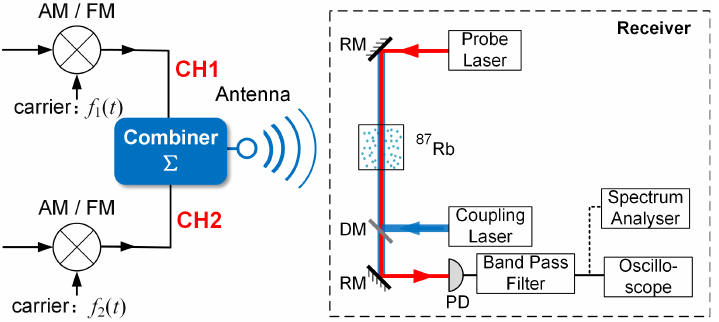
Figure 1. The experimental set-up. Frequency division multiplexing (FDM) receiver basing on Rydberg atoms is shown in the right part. Abbreviations: RM: reflector mirror; DM: dichroic mirror; PD: photodetector.